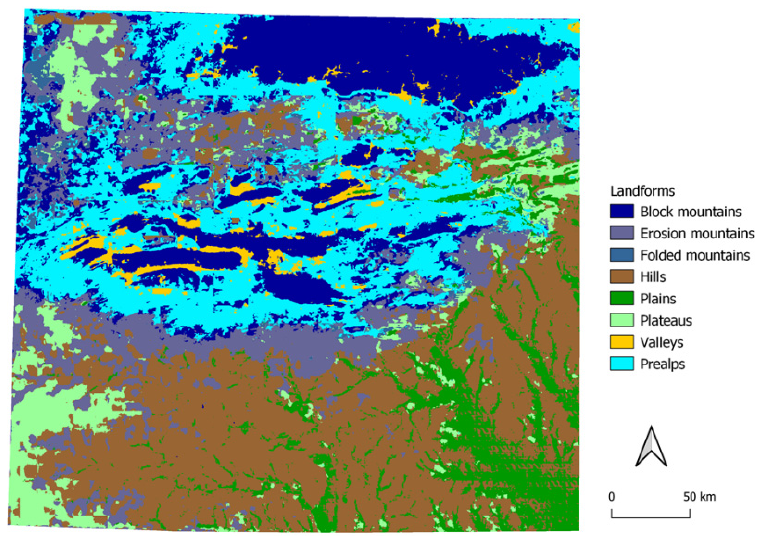
Figure 13. Predictions for the Ouachita Mountains.